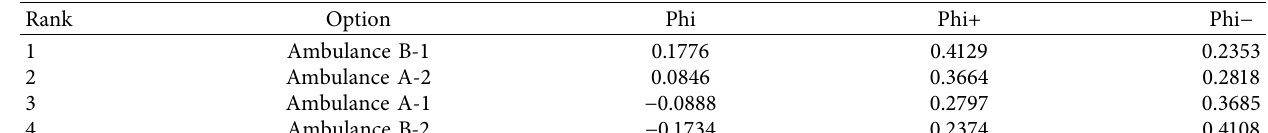
Table 8: Flow values calculated for patient transport vehicles by PROMETHEE.